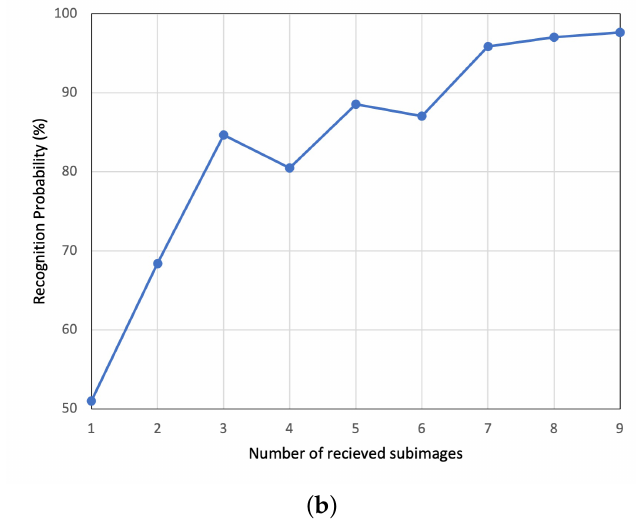
Figure 9. Progressive recognition of Caltech101 Seahorse test image. ( a ) Improvement in visual quality as more subimages are received. ( b ) Probability trend with increase in number of subimages received.